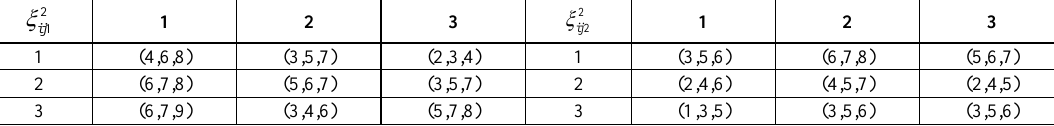
Table 2. The damage costs for the two conveyances train and cargo